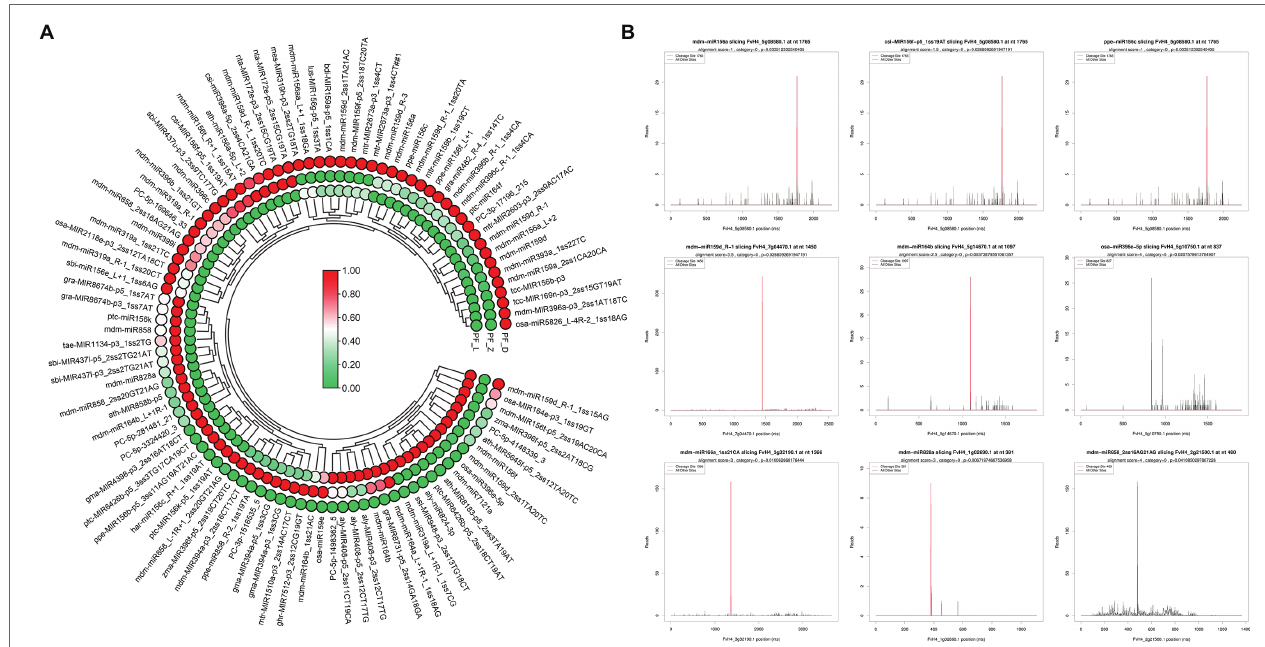
FIGURE 4 | Differentially expressed miRNAs involved in anthocyanin biosynthesis and target (T) plots of miRNAs verified by degradome sequencing. (A) Heatmaps showing the expression patterns of the differentially expressed miRNAs involved in anthocyanin biosynthesis. (B) The plots of the targets cleaved by the corresponding miRNAs from the degradome library. The red line represents the predicted cleavage sites of the corresponding